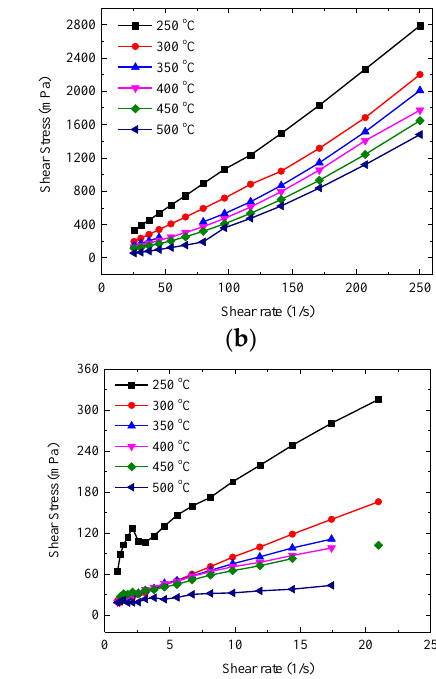
Figure 6. Comparison of present experimental results of viscosities with experimental data reported in the literature [25,27,40 – 48]. ( a ) HITEC salt; ( b ) solar salt.